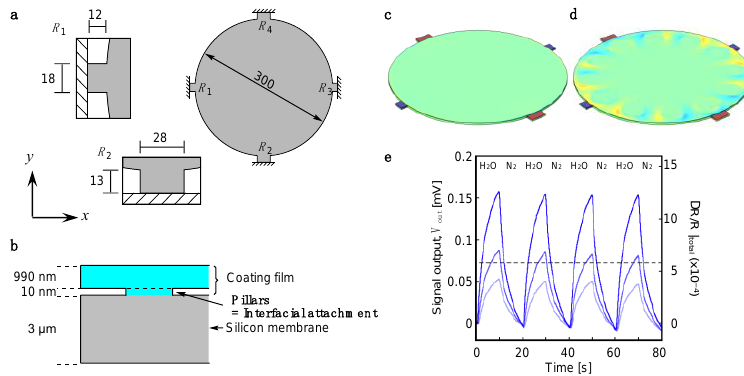
Figure 1. Geometry of a partially attached interface model. ( a ) Configuration of an MSS. The piezoresistor-integrated sensing beams are magnified in the insets. All images are illustrated in top-view. Numbers indicate the dimensions in µ m. ( b ) Cross-sectional image of a pillar as an interfacial attachment. The height of pillars is fixed at 10 nm with various radius, r pillar . ( c,d ) The results of the FEA simulations for the conventional fully attached model ( c ) and partially attached model ( d ), respectively. The distributions of relative resistance changes are plotted as a color gradient. ( e ) Typical signal output of the MSS measured in the experiments. Poly(methyl methacrylate) (PMMA) was coated on the surface of the membrane. E f , ν f and t f are approximately 3 GPa, 0.4 and 1 µ m, respectively. Signal outputs were measured at the bias voltage V B of –1.0 V. The concentrations of water vapor P a / P o are set to 2%, 3% and 5%, where P a and P o stand for the partial pressure and saturated vapor pressure, respectively. Black dashed line indicates the level of total resistance change ( ∆ R / R | total = 5.82 × 10 − 4 ) simulated by FEA for the fully attached model ( E f = 3 [GPa], ν f = 0.4, t f = 1 [ µ m], ε f = 1 × 10 − 5